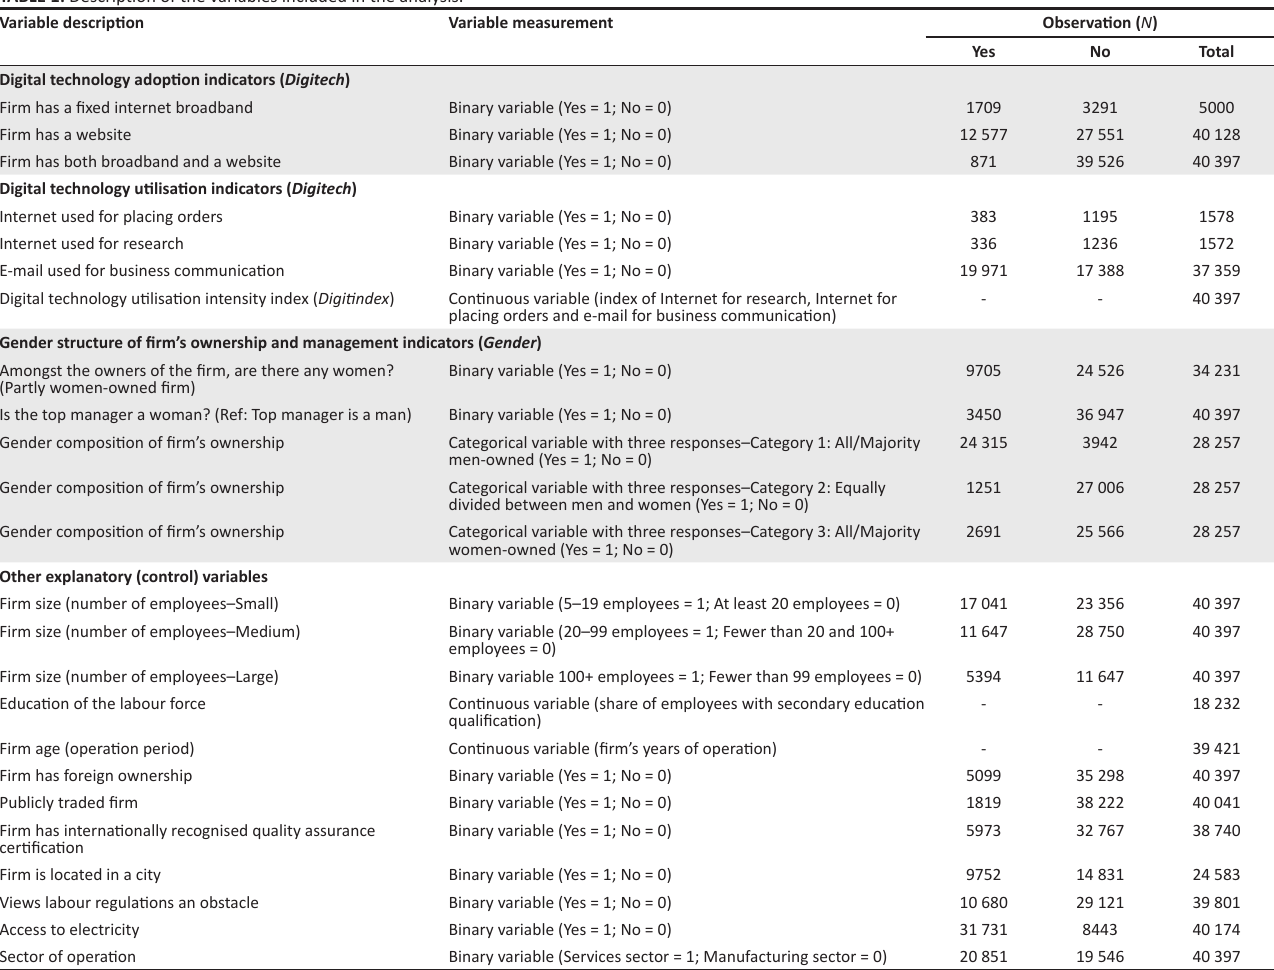
TABLE 1: Description of the variables included in the analysis. Variable description Variable